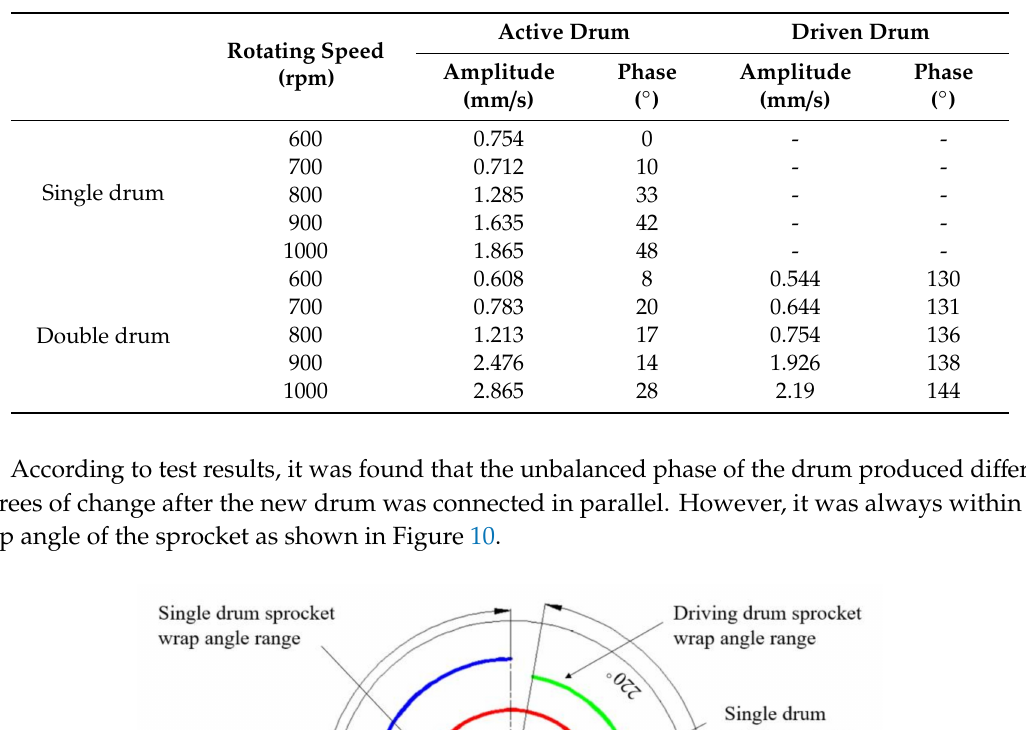
Table 4. Unbalance of each active and driven drum at di ff erent speeds.